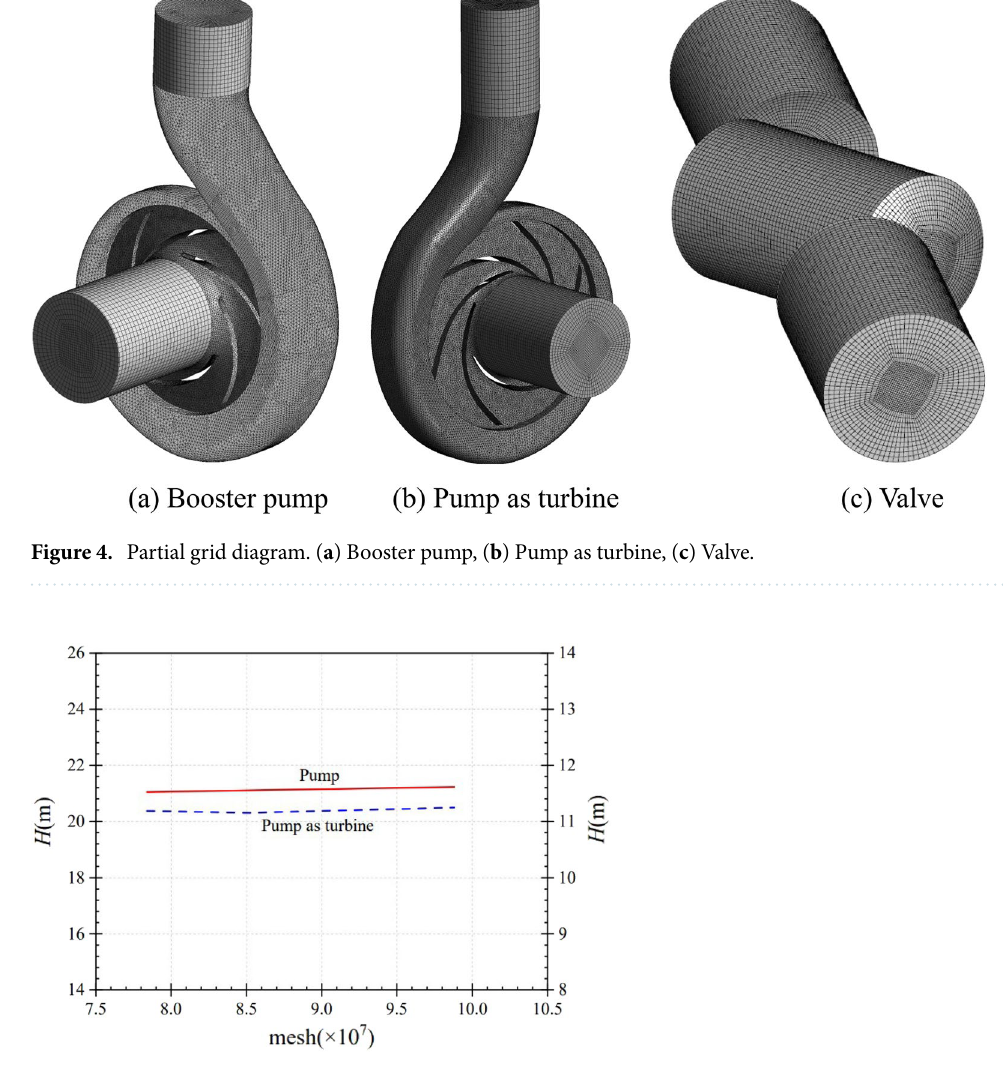
Figure 5. Independence of the grid